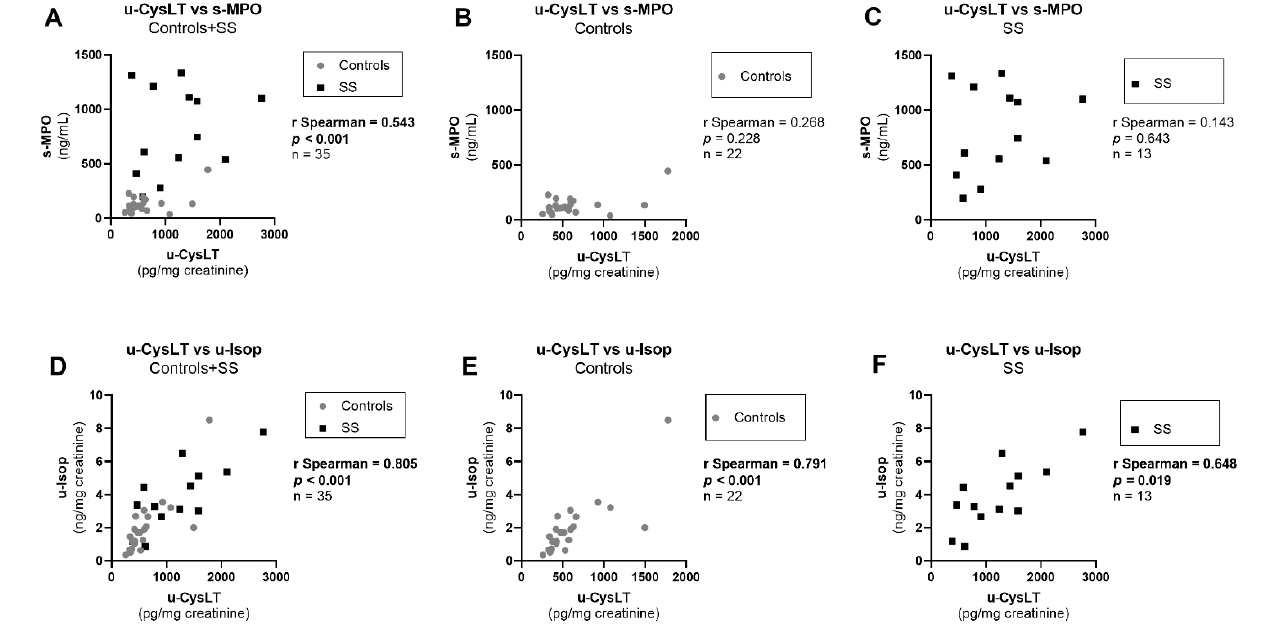
Figure 6. Correlation between u-CysLT and markers of inflammation and oxidative stress at admission in the overall study population and separately in controls and in SS: ( A ) u-CysLT vs. s-MPO in Controls + SS; ( B ) u-CysLT vs. s-MPO in Controls; ( C ) u-CysLT vs. s-MPO in SS; ( D ) u-CysLT vs. u-Isop in Controls + SS; ( E ) u-CysLT vs. u-Isop in Controls; ( F ) u-CysLT vs. u-Isop in SS. s-MPO, serum myeloperoxidase; u-CysLT, urinary cysteinyl leukotrienes; u-Isop, urinary isoprostanes. The values of u-CysLT and u-Isop were corrected for the respective urinary creatinine concentrations.